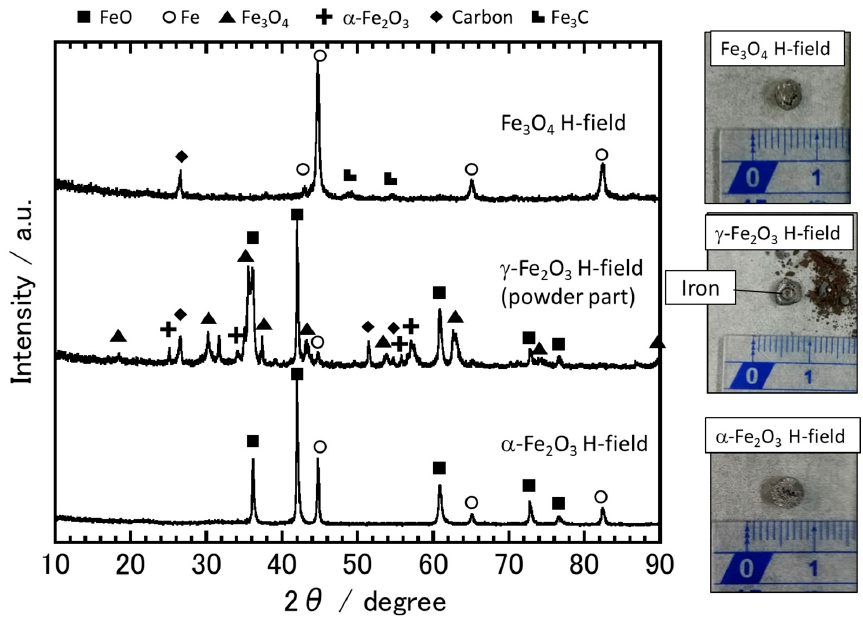
Figure 6. XRD results and photographs of the sample after irradiation with H-fields.